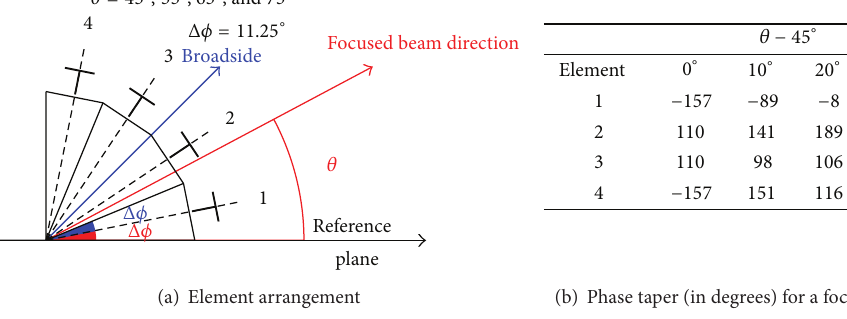
Figure 15: Configuration of a 4-element circular array.